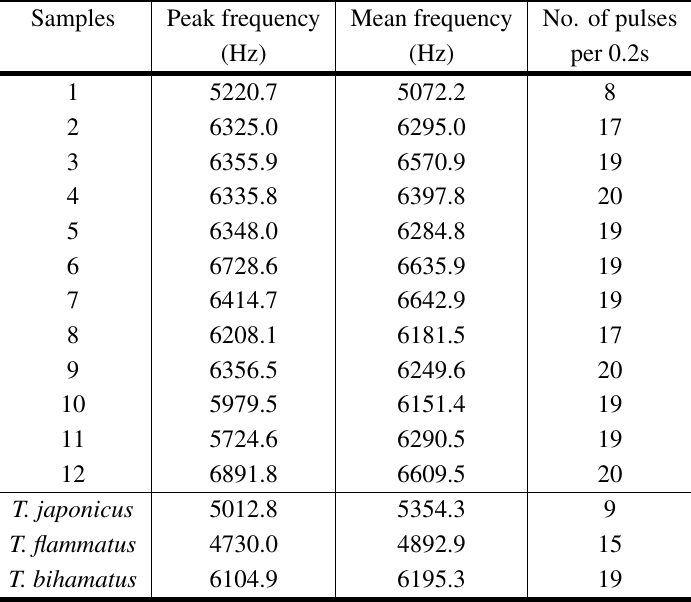
Peak and mean frequencies and number of pulses in the songs of Tibicen specimens and